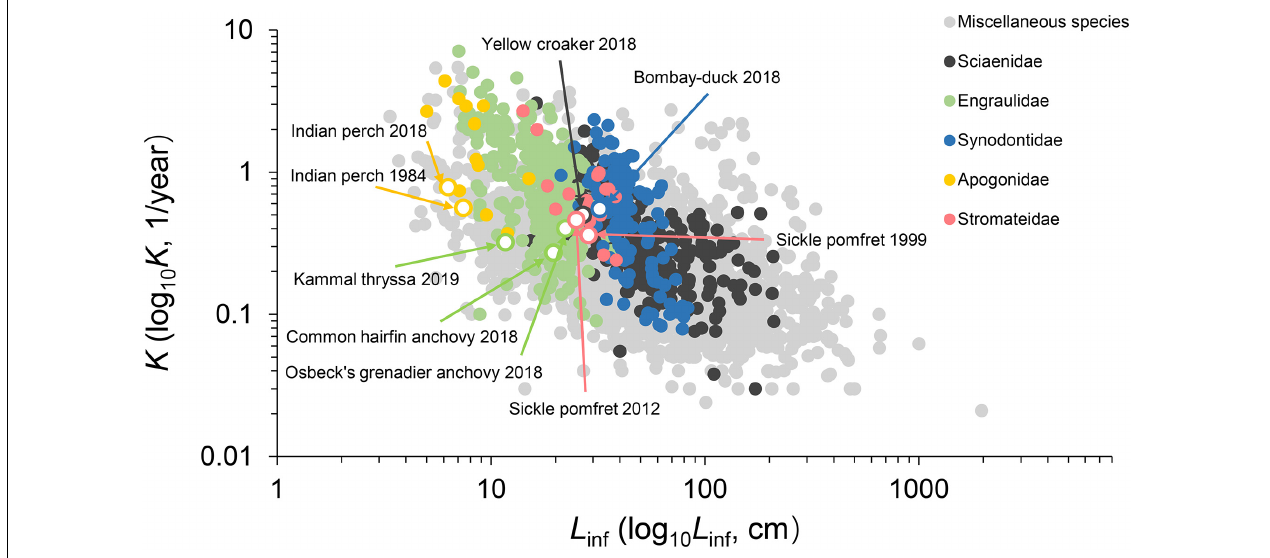
FIGURE 5 | The auximetric plot with the growth spaces of five families (filled circles) and the growth position estimates for the seven fish stocks in question (hollow circles).